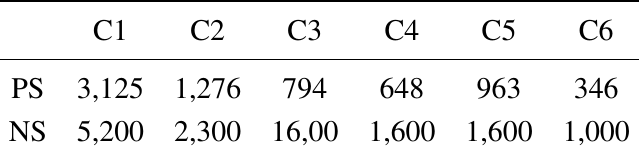
Table 2. The number of PS and NS for the six trained classifiers.